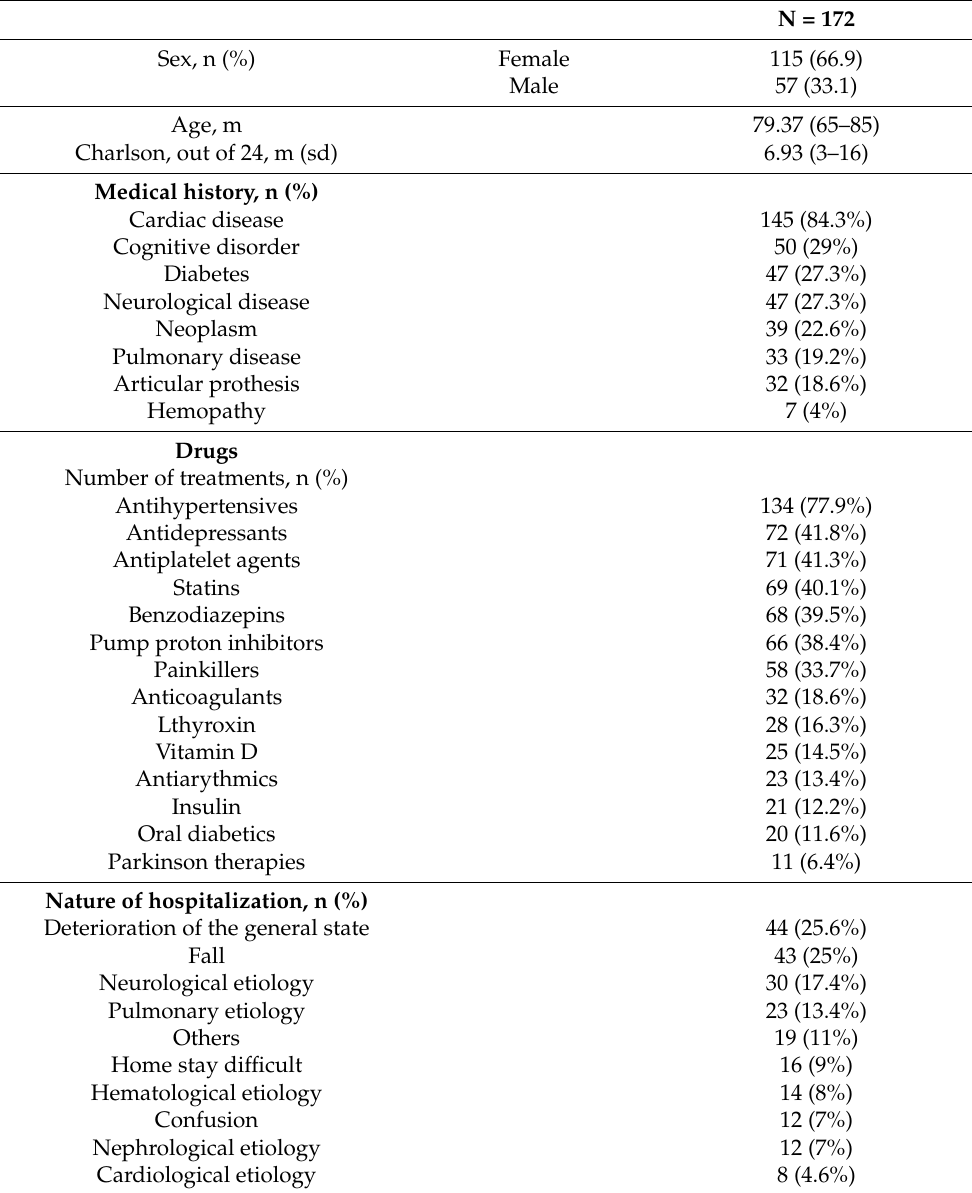
Table 1. Description of the sample